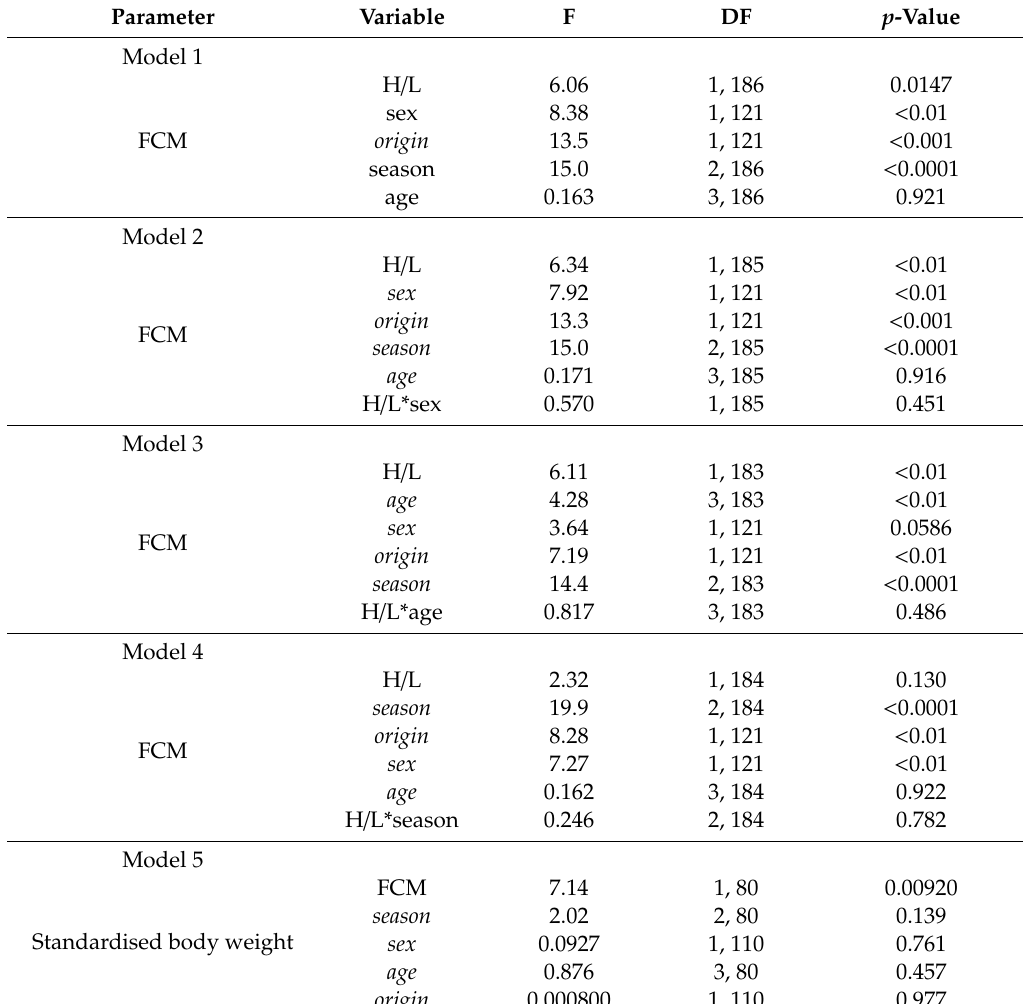
Table 2. Results from linear mixed-e ff ects models for FGM concentrations and body weight as dependentvariables: dependentvariable(parameter), independentandconfoundingvariables(variable, confounding variables in italics), interactions (asterisk), F-value (F), degrees of freedom (DF), and p -value. The statistics of the main e ff ects reported in the results section are from Model 1 (for a residual QQ plot indicating the model fit of Model 1 see Figure